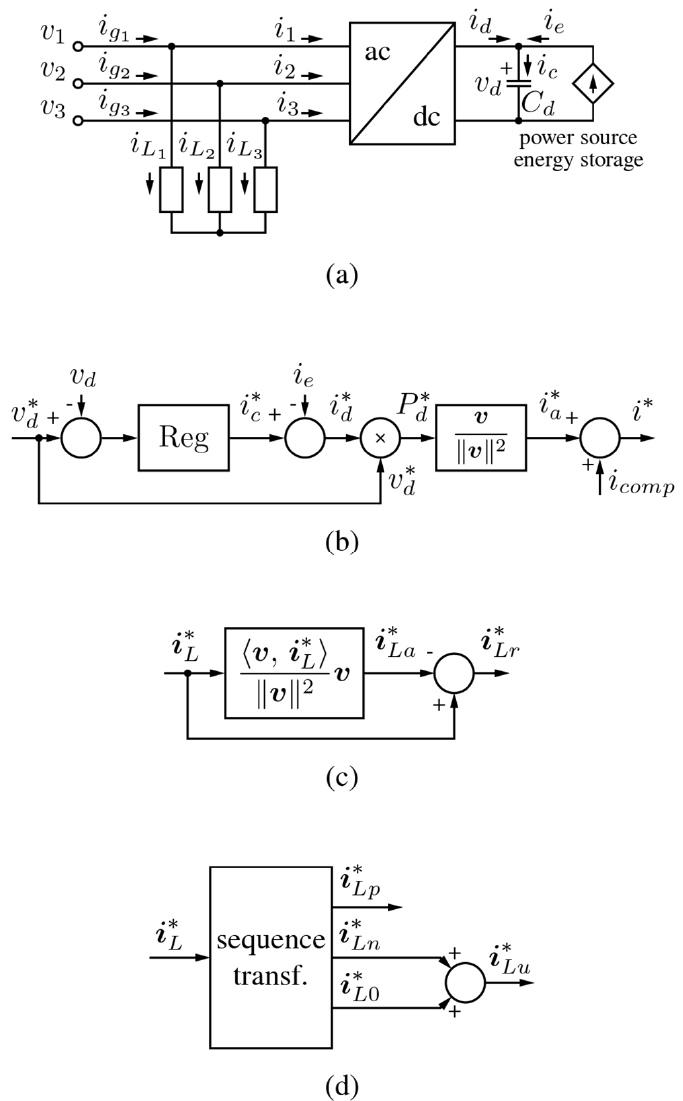
Figure 4. Control quantities at active node (i.e., inverter) level. ( a ) general structure of active nodes; ( b ) DC voltage control and AC current references; ( c ) determination of active and reactive load currents; ( d ) determination of unbalance current references.